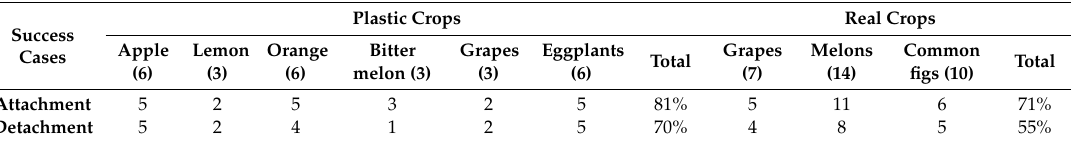
Table 1. Harvesting results for plastic and real